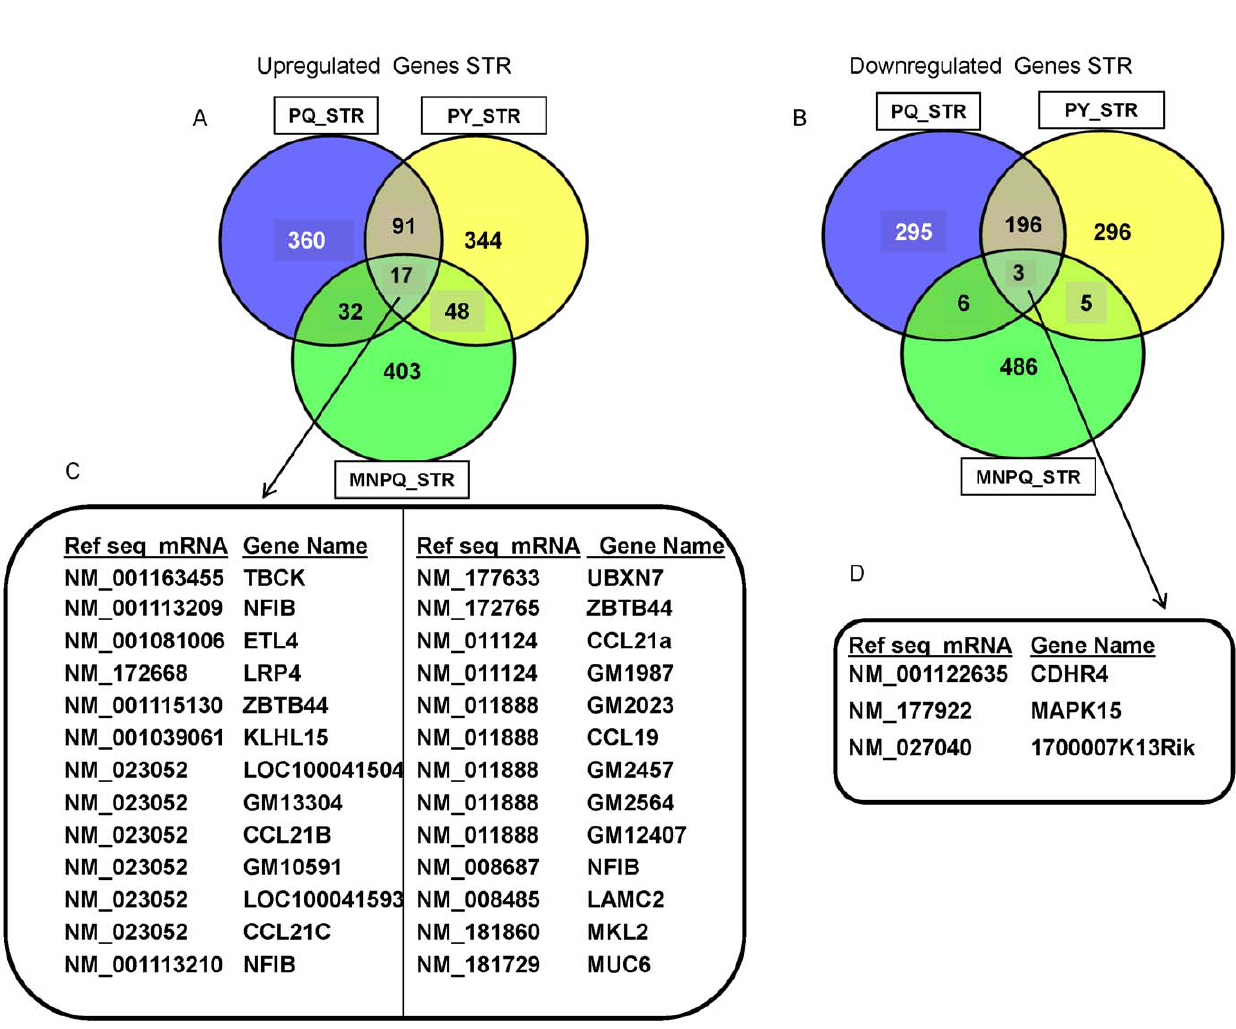
Figure 4. Common genes in the STR between PQ, PY and MNPQ mouse models of PD. A) Venn diagram of 500 up-regulated STR transcripts from PQ, PY and MNPQ models of PD. B) Venn diagram of 500 down-regulated STR transcripts from PQ, PY and MNPQ models of PD. C) Common up-regulated genes in the STR of PQ, PY and MNPQ models of PD. D) Common down-regulated genes in the STR of PQ, PY and MNPQ models of